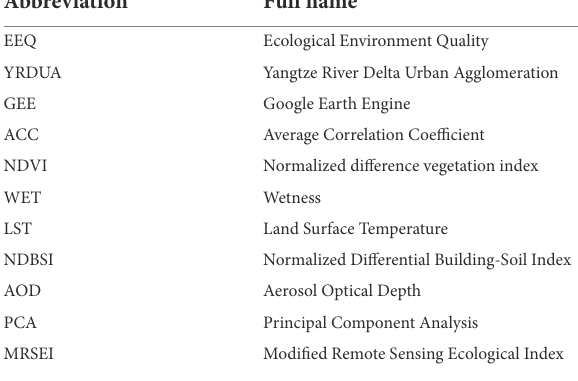
TABLE 1 List of